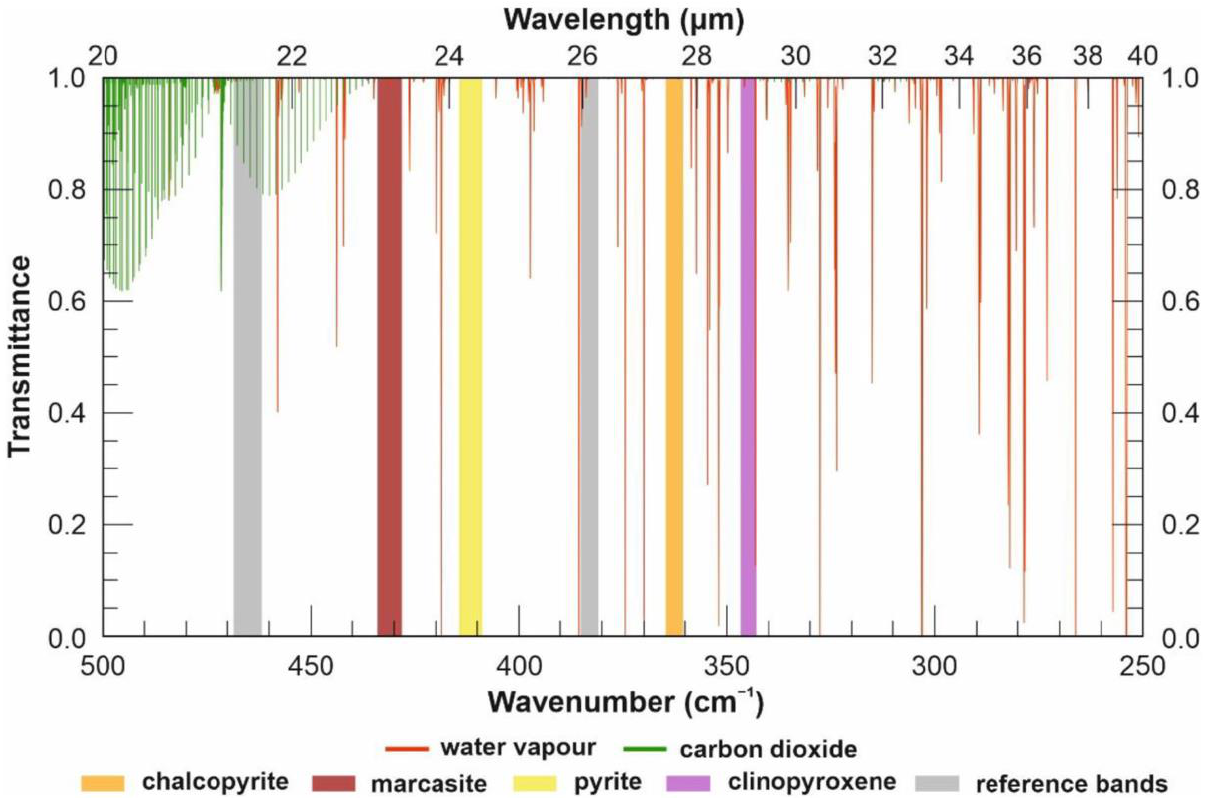
Figure 4. Exact positions of H 2 O (red) and CO 2 (green) lines in the wavelength range covered by MIRORES. The values of H 2 O and CO 2 absorption coefficients are from the HITRAN database [48], and details of the applied model are in Supplementary Material 2 (IDL